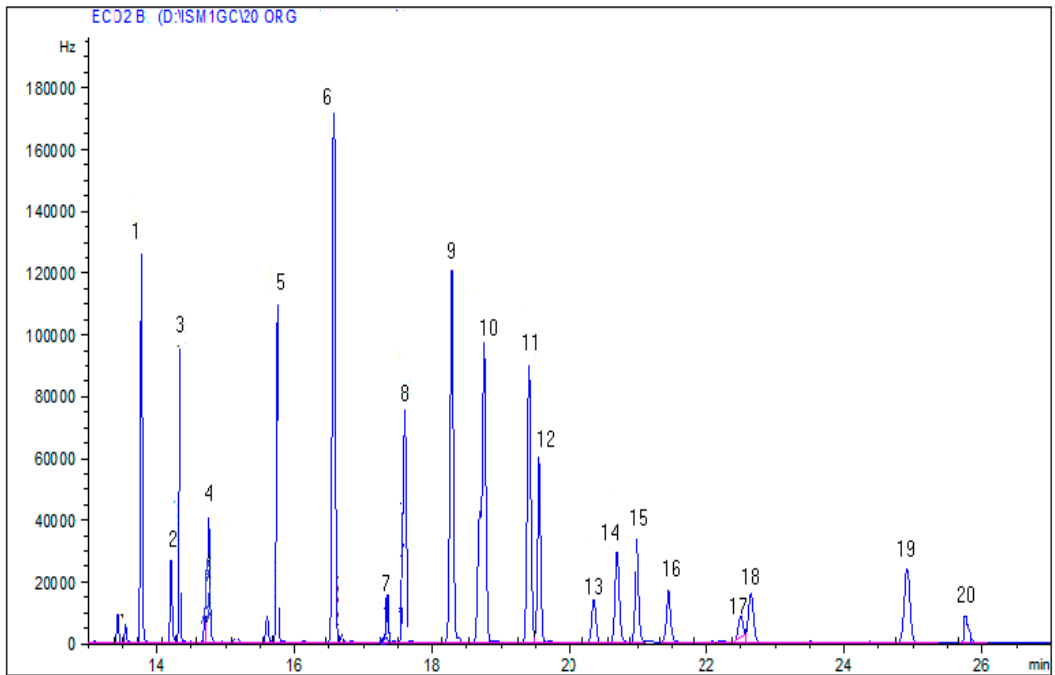
Figure 2. A typical chromatogram for 20 organochlorine pesticides standard and peaks identification: (1) α -BHC, (2) β -BHC, (3) γ -BHC, (4) δ -BHC, (5) heptachlor, (6) aldrin, (7) heptachlor epoxide, (8) γ -chlordane, (9) α -chlordane, (10) endosulfan I, (11) 4,4 ′ -DDE, (12) dieldrin, (13) endrin, (14) endosulfan II, (15) 4,4 ′ -DDD, (16) endrin aldehyde, (17) endrin ketone, (18) 4,4 ′ -DDT, (19) endosulfan sulfate, (20) methoxychlor.